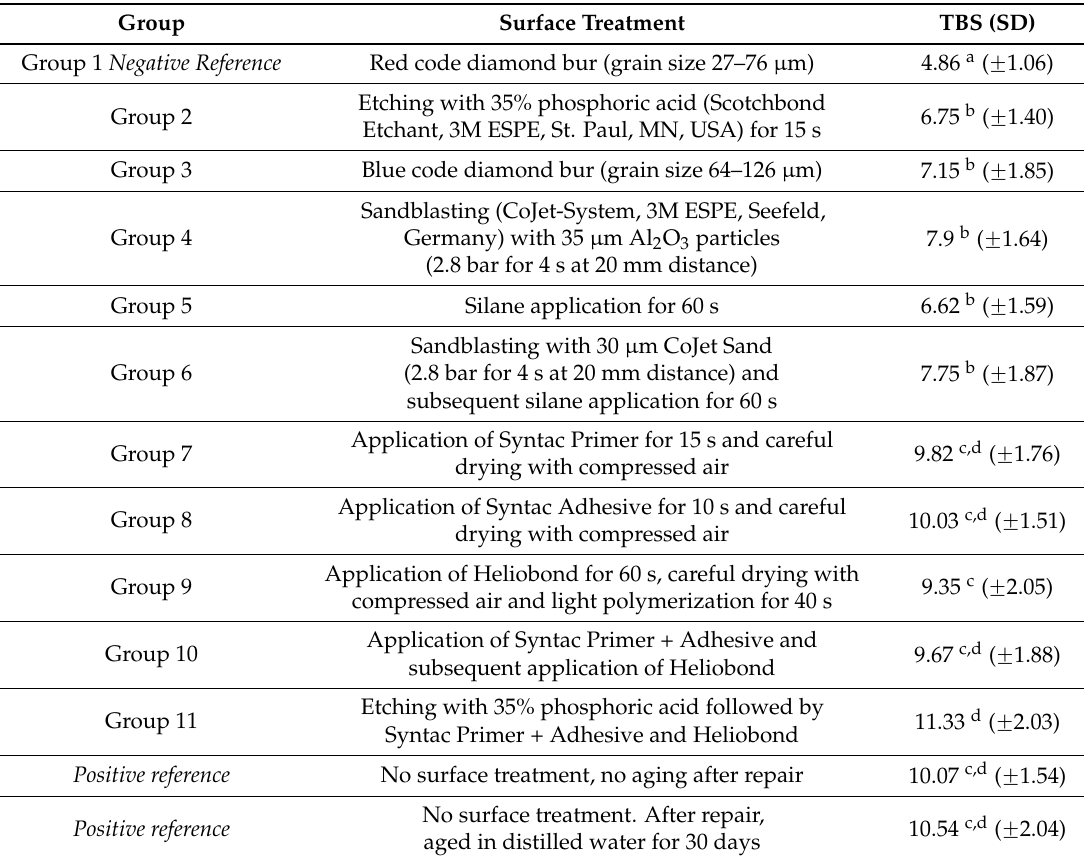
Table 1. Surface treatments and tensile bond strength (TBS) results (MPa).